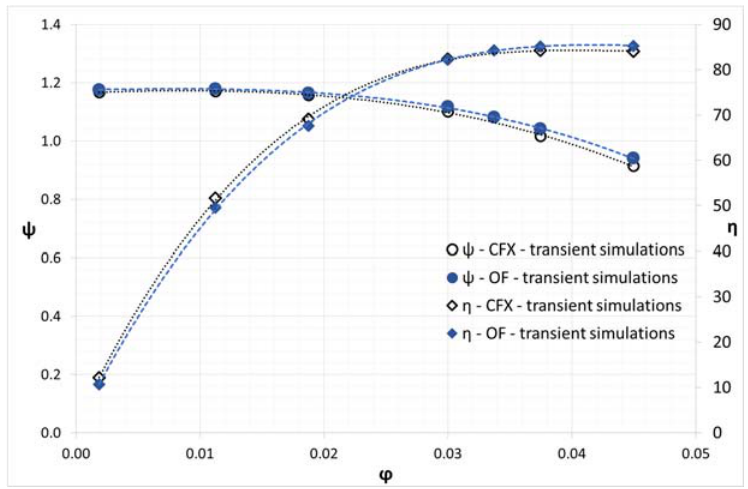
Figure 2. Comparison of the ψ ‐ φ and η ‐ φ curves calculated with CFX and